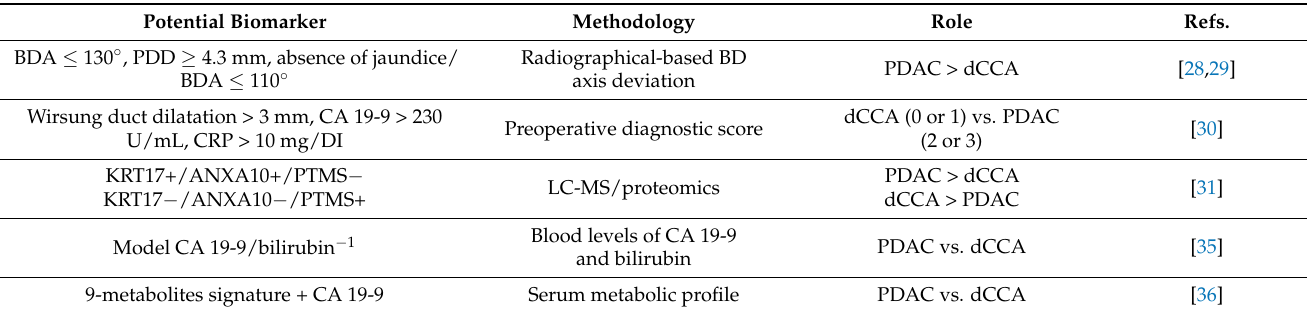
Table 1. List of biomarkers with potential PDAC vs. dCCA diagnostic